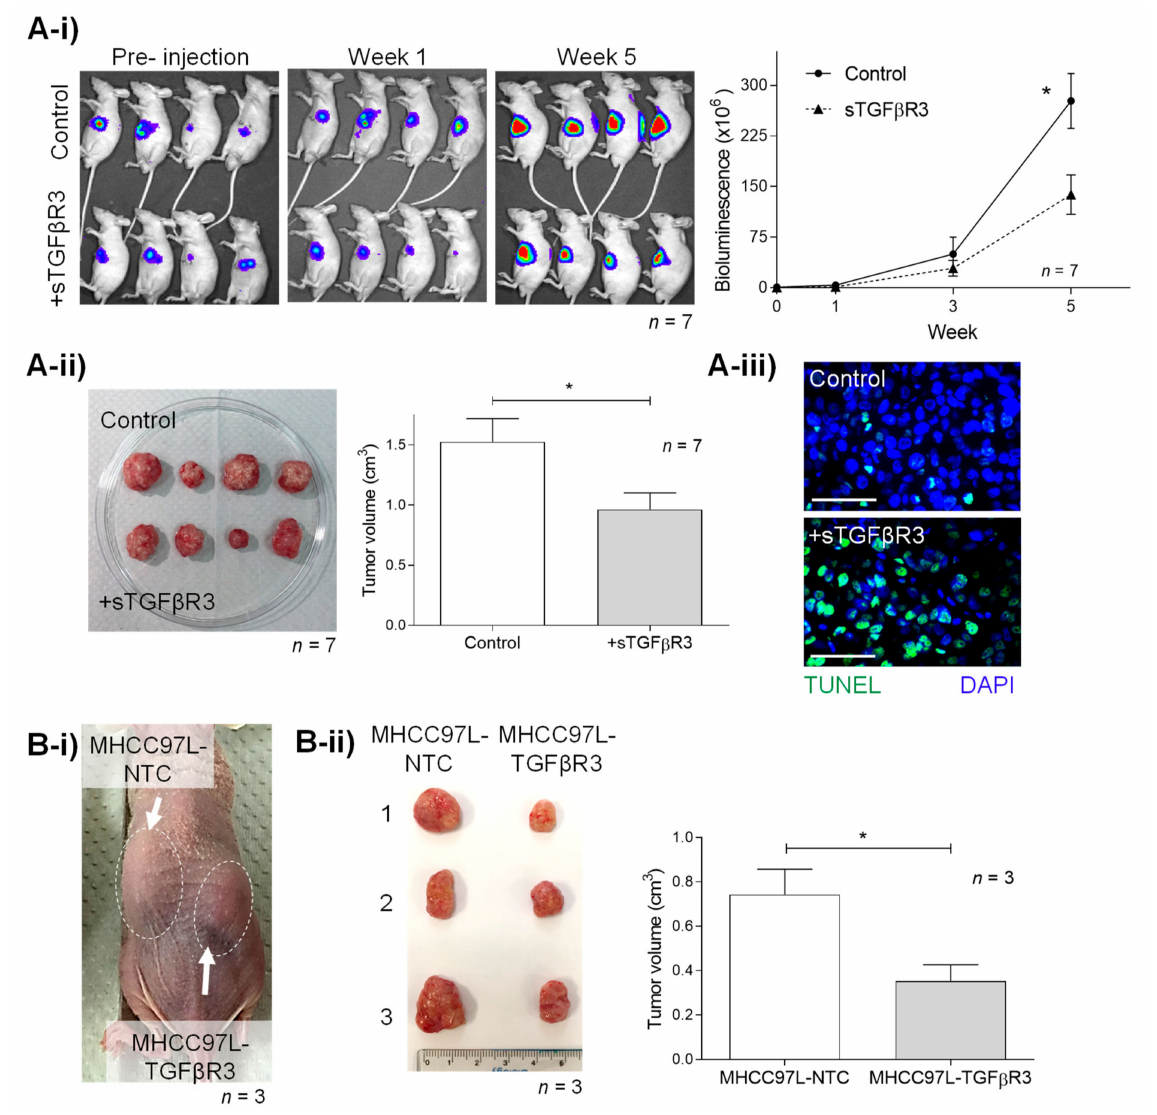
Figure 3. In vivo study of tumor-suppressive roles of ( A ) sTGF β R3 and ( B ) TGF β R3. (A) Male athymic mice bearing orthotopically grafted MHCC97L-Luciferase tumoral were injected with PBS (negative control) and 25 µ g sTGF β R3 ( n = 7) peritoneally weekly. ( A-i ) Monitoring of in situ tumor growth by Xenogen IVIS before and 1–5 week after injection with measurements of mean in vivo liver tumor bioluminescence of each group over time. Bioluminescent signals were quantified as photons/s at each imaging timepoint. ( A-ii ) Following euthanasia, tumor volume was examined and measured in each mouse. ( A-iii ) TUNEL staining of liver tumor tissues in the treatment and control group. ( B-i ) Subcutaneous tumor model setup of tumor nodule induced by MHCC97L-NTC (control) on the left flank and MHCC97L-TGF β R3 (knock-in) on the right flank in each mouse ( n = 3). ( B-ii ) Tumor volume was examined and measured after scarification in week 4. * p < 0.05. Scale bar: 100 µ m. Error bar indicated SEM. (Unpaired t